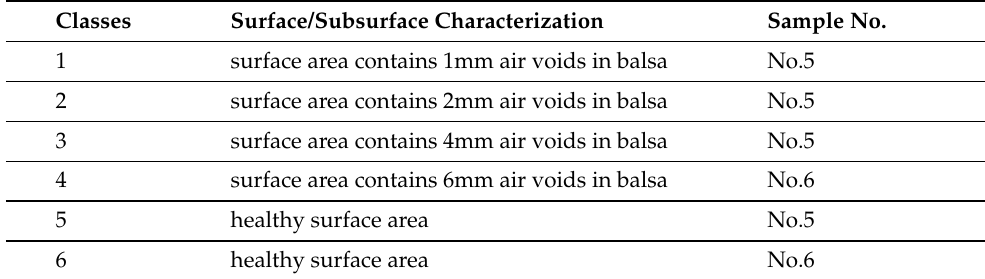
Table 6. Characterization classes for air voids defect.